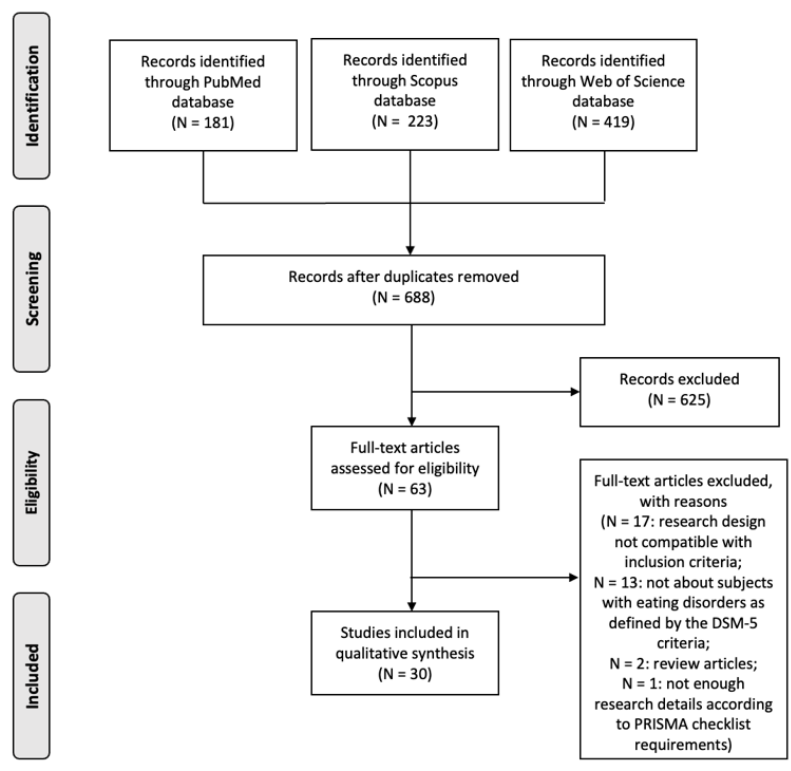
Figure 1. PRISMA flowchart of the study selection process.